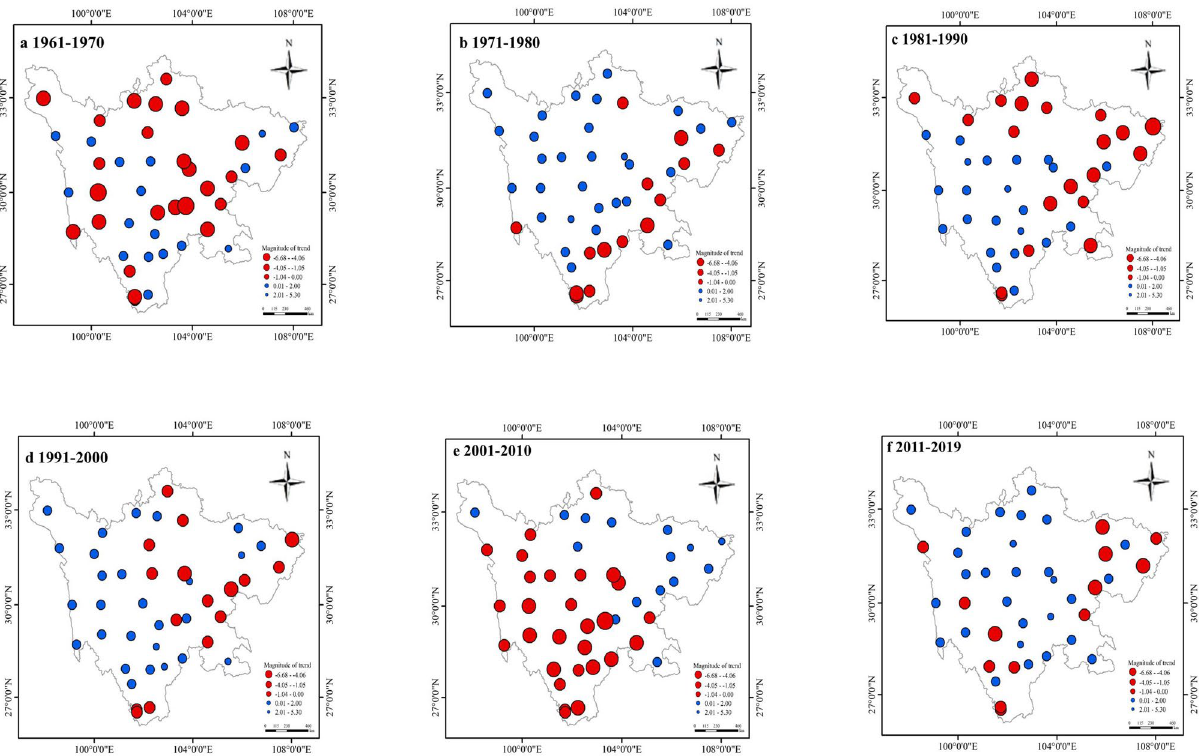
Figure 3. MK Trend test coefficient of precipitation in Sichuan province on different time scales (1961–1970s, 1971–1980s, 1981–1990s, 1991–2000s, 2001–2010s, 2011–2019s), red represents a negative trend and blue represents a positive trend. (The figure was generated by ArcGIS 10.6 software, https ://deskt op.arcgi